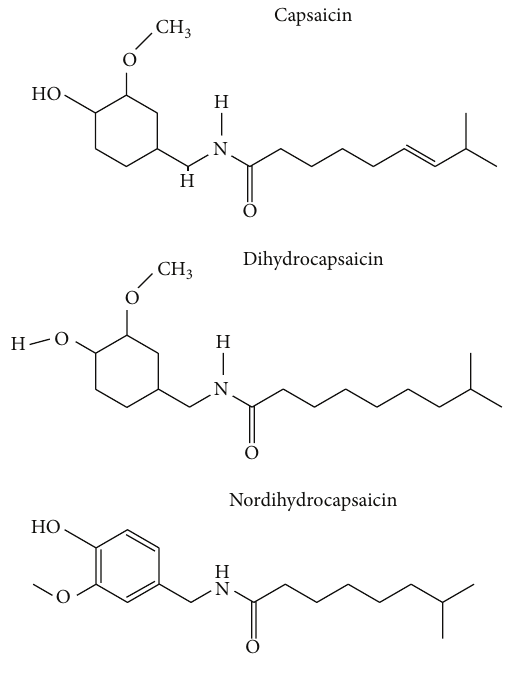
Figure 1: The structures of